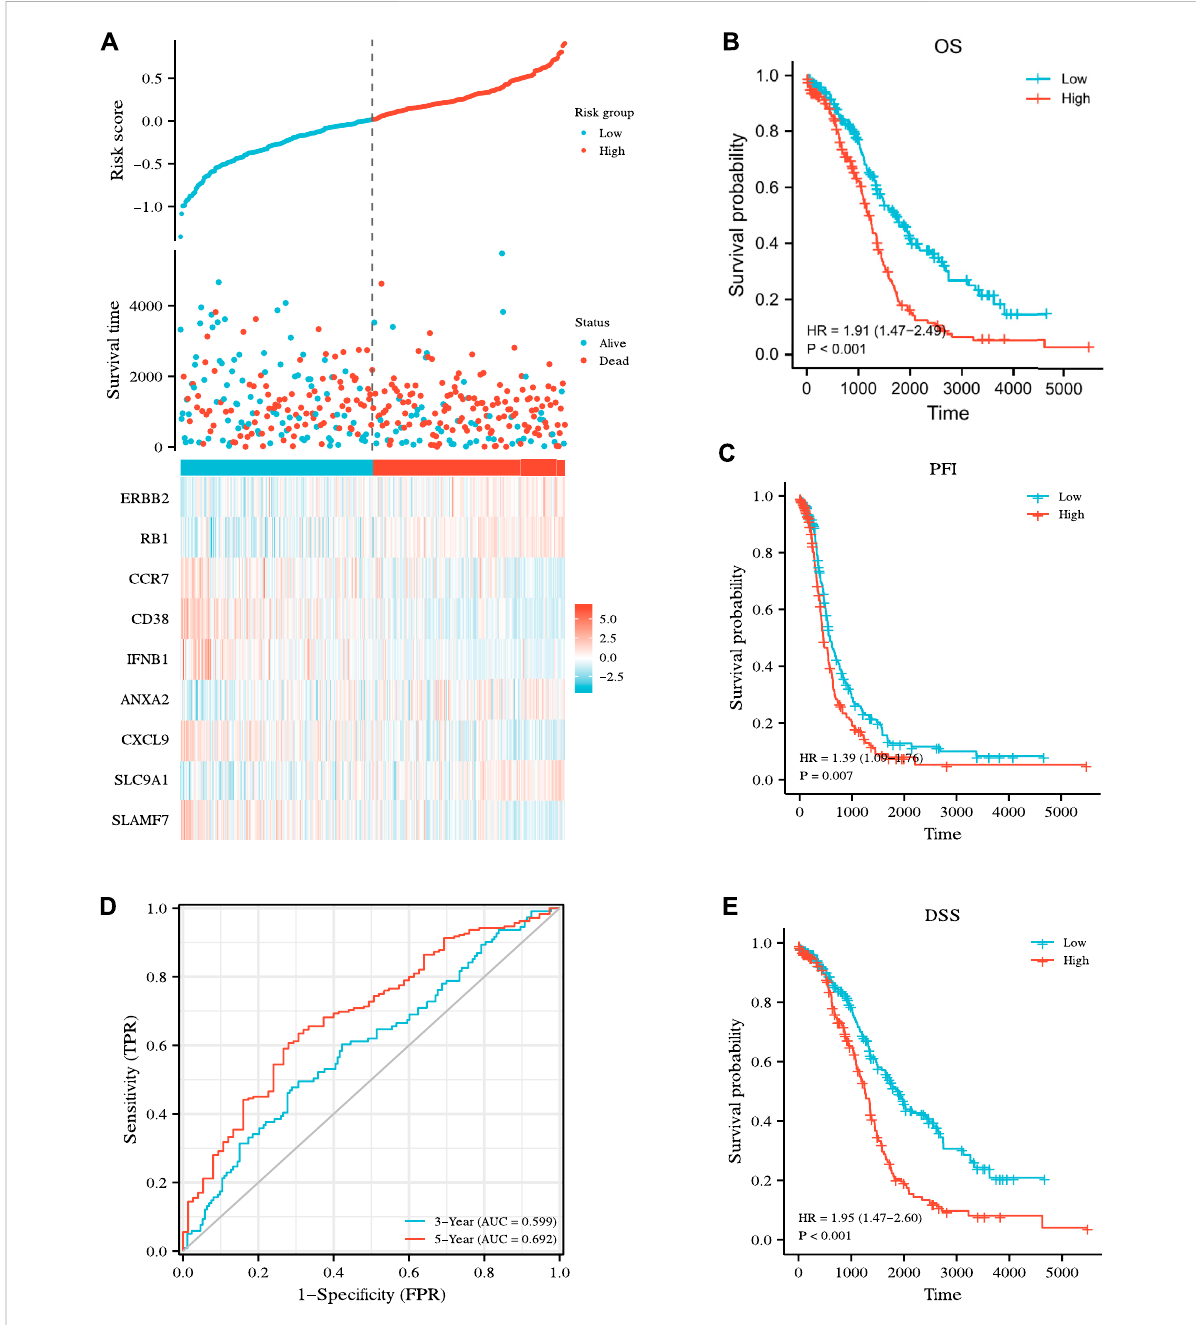
FIGURE 6 Prognostic analysis of the nine-gene signature model in the TCGA cohort. (A) Distribution of risk score, OS, survival status (blue dots indicate alive, red dots indicate death) and the expression heatmaps of nine genes. (B,C,E) Kaplan – Meier analysis of OS, PFI, DSS curves in the low- or high- risk subgroups of patients with OC. (D) AUC of time-dependent ROC curves for the prediction of 3- and 5-year OS in